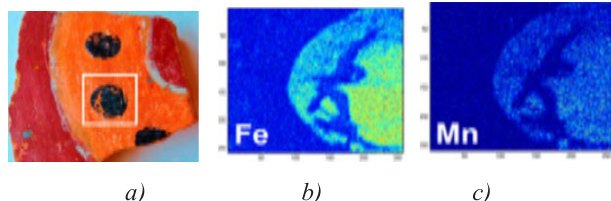
Fig. 3. Elemental maps resulting from the inspection of one ceramic shard: a) optical image; b) Fe-content, c) Mn content